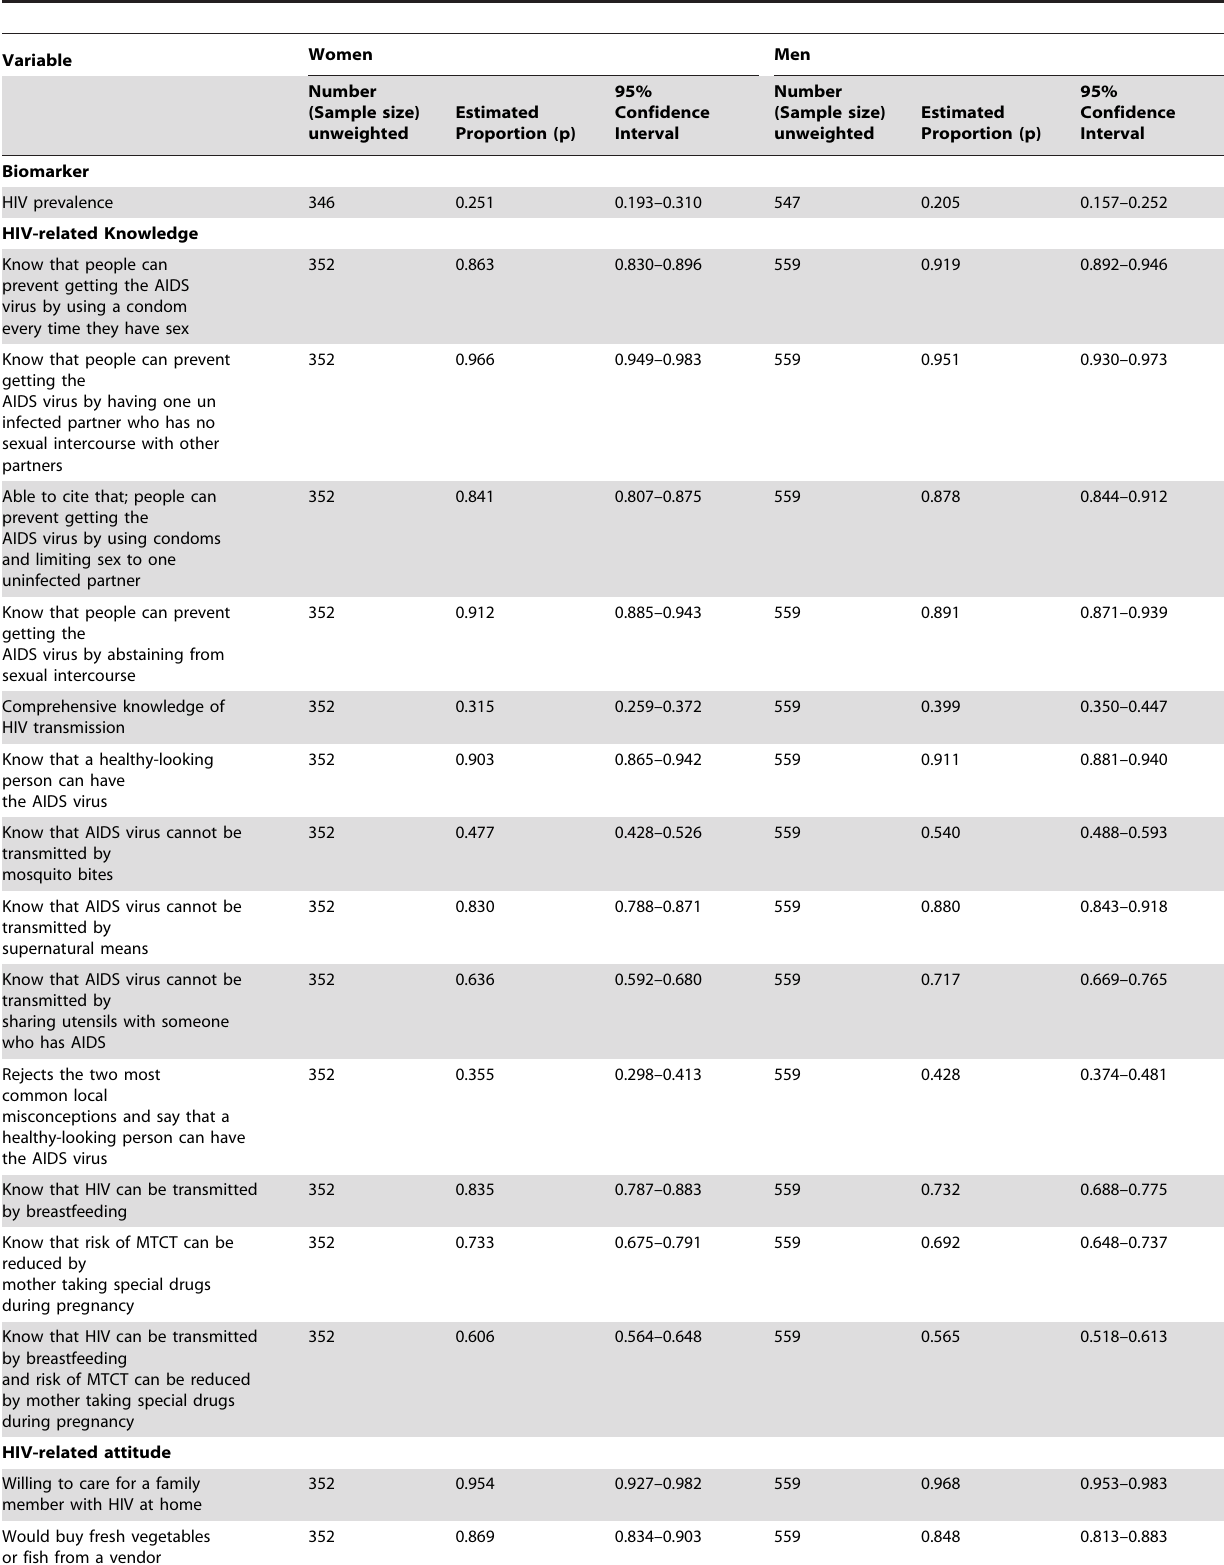
Table 2. Estimated prevalence of HIV-related knowledge, behavior, care and biomarker variables among women and men age 15– 49